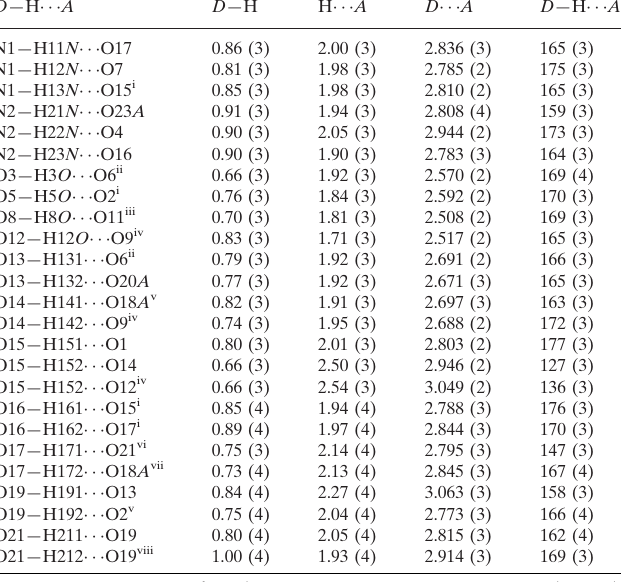
Hydrogen-bond geometry (A˚ , (cid:3)